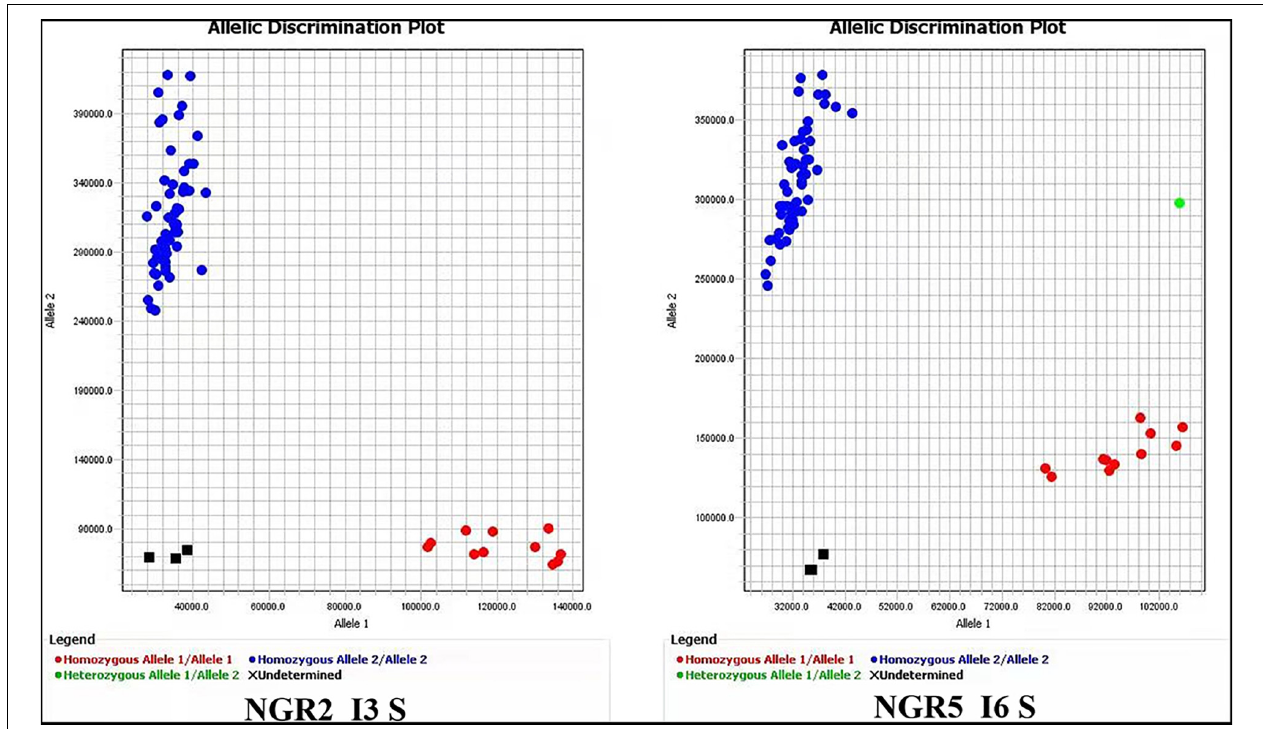
FIGURE 2 | PAMRS markers for NGR2 and NGR5. The accessions used for marker evaluation were the 41 germplasm accessions in Supplementary Table S16 and the first 16 accessions in Figure 1 .